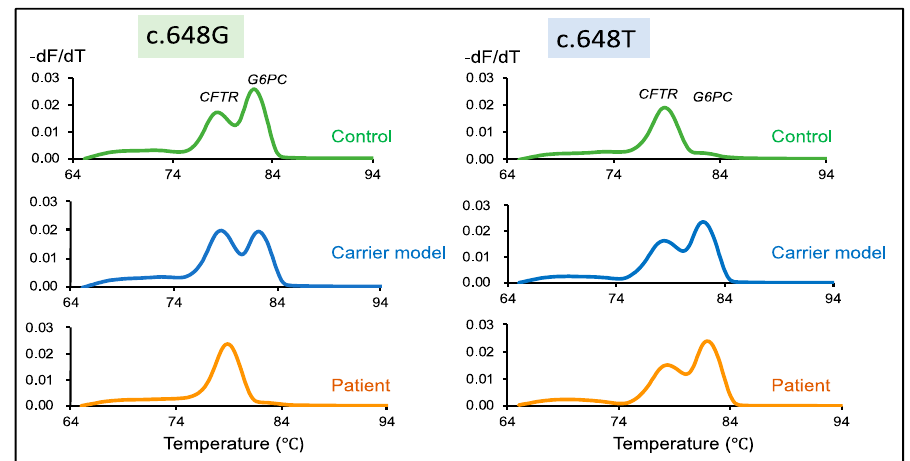
Figure 3. Detection of wild-type and mutant G6PC peaks in healthy control samples (c.648G), the carrier model (c.648G/T), and patient samples (c.648T). Melting peaks of samples generated from multiplex PCR of CFTR and wild-type G6PC c648G-specific primers. Two distinct peaks corresponding to CFTR and G6PC are disclosed by both the control and the carrier. However, only one melting peak corresponding to CFTR is detected from the patient. Melting peaks of a healthy control, carrier model, and patient samples generated from multiplex PCR of CFTR and mutant G6PC c648T-specific primers. Only a single peak is observed in the control, whereas the carrier model and patient samples disclosed two distinct peaks. Green, blue, and orange lines indicate healthy controls, the carrier model, and patients, respectively.